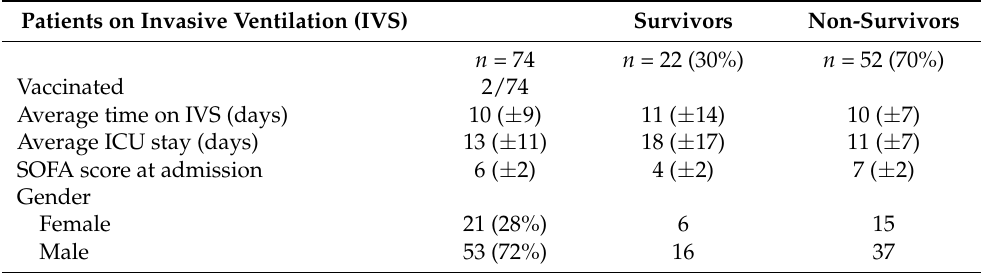
Table 3. Outcome and patient characteristics for patients on